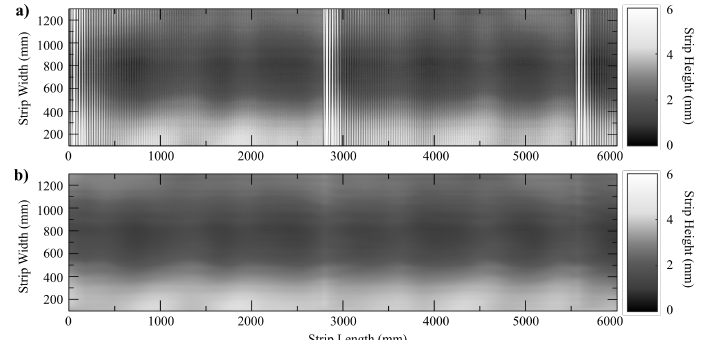
Figure 11. ( a ) Sensor raw data for a S235JR steel coil with observed high frequency transient noisy waves and background noise. ( b ) Denoised sensor data using the proposed Hermite interpolation filtering method.